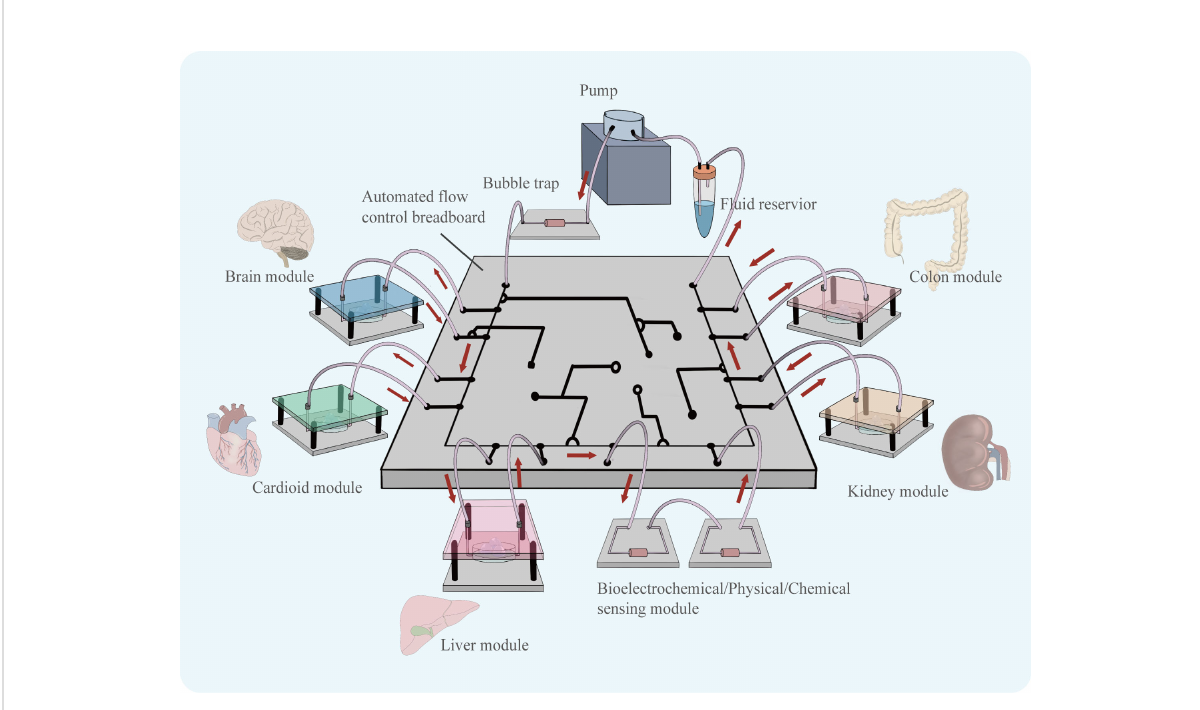
FIGURE 6 Organoids of various organs can be derived using similar culture patterns. Assembling cultured organoid models in a chip controlled by a micro fl uidic system, the fl ow of fl uid can simulate the fl ow of material between organs. The organoids-on-a-chip is able to simulate drug therapy in a multi-organ co-culture